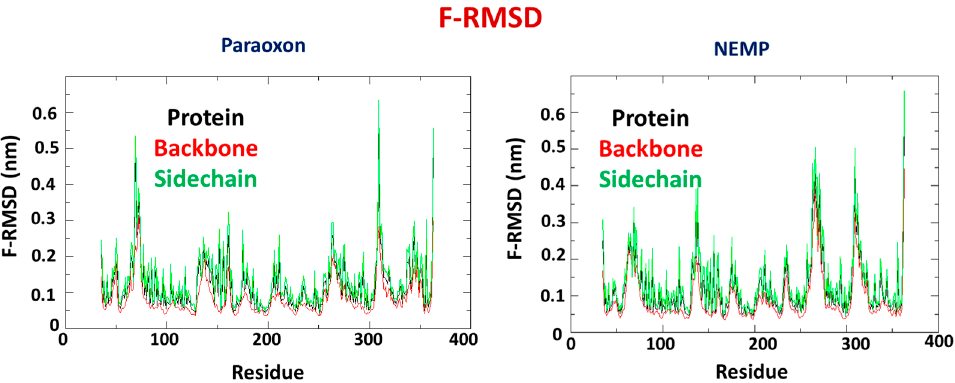
Figure 7. RMSD fluctuation (F-RMSD) plots for PTE / PXN and PTE / NEMP during 50 ns of MD simulation.